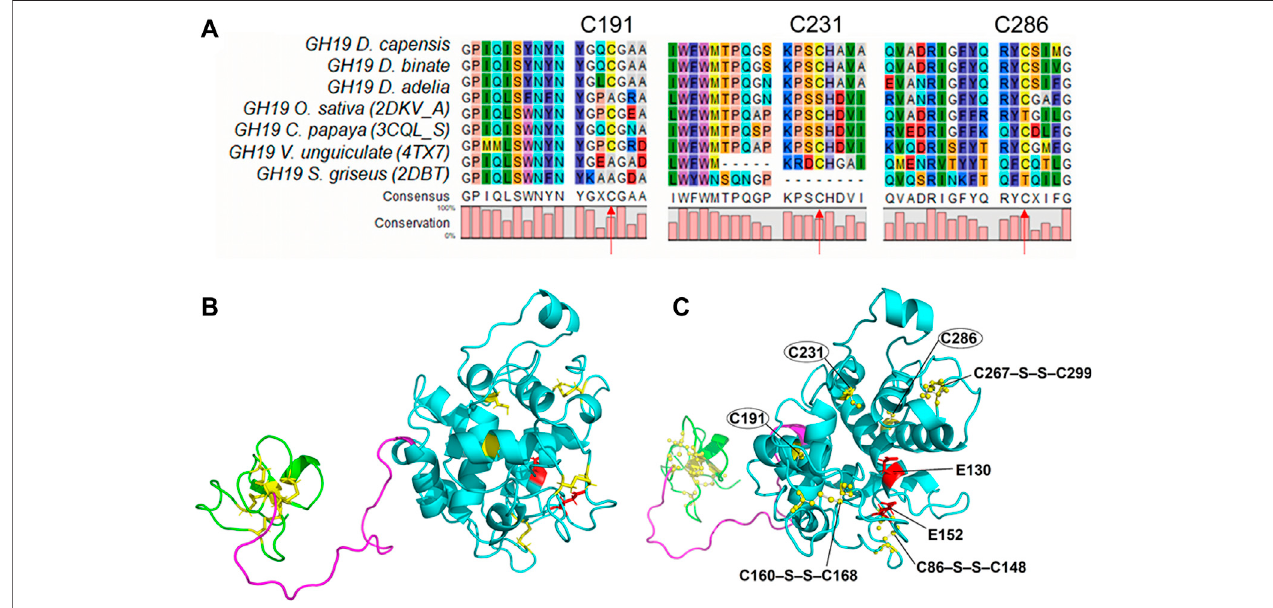
FIGURE5| Proteinalignmentofhomologouschitinasesintheareasofunbondedcysteine s:(A) Alignmentofthesevenchitinasesequencesthatwereselected. (B) Structure of Chit19 homology model with the three domains including chitin binding domains (ChBD, residues 1 – 40, green), linker (residues 41 – 65, magenta), and core domain (residues 68 – 306, cyan), and highlighted disul fi de bonds (yellow) and putative catalytic residues (E130 and E152, red)). Secondary structures are highlighted as ribbon models (indicating α -helices, ß-sheets, and loop regions). (B) and (C) represent the same structure but in (C) the snapshot angle is rotated to highlight the putativecatalytic sitesandthedisul fi debridges(ballsandsticks)ofthecoredomain(C86 – S – S – C148,C160 – S – S – C168,C267 – S – S – C299)aswellasthefreecysteines (C191, C231,